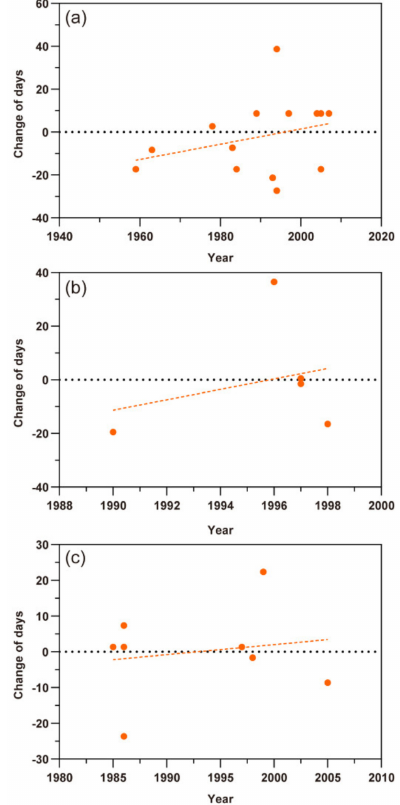
Figure 6. Scatter plots of the last occurrence dates of three aphid pests. The dots represent di ff erent records and the dashed lines show the trends of the last occurrence. ( a ) Myzus persicae ; ( b ) Aphis gossypii in northern Xinjiang; ( c ) A. gossypii in southern